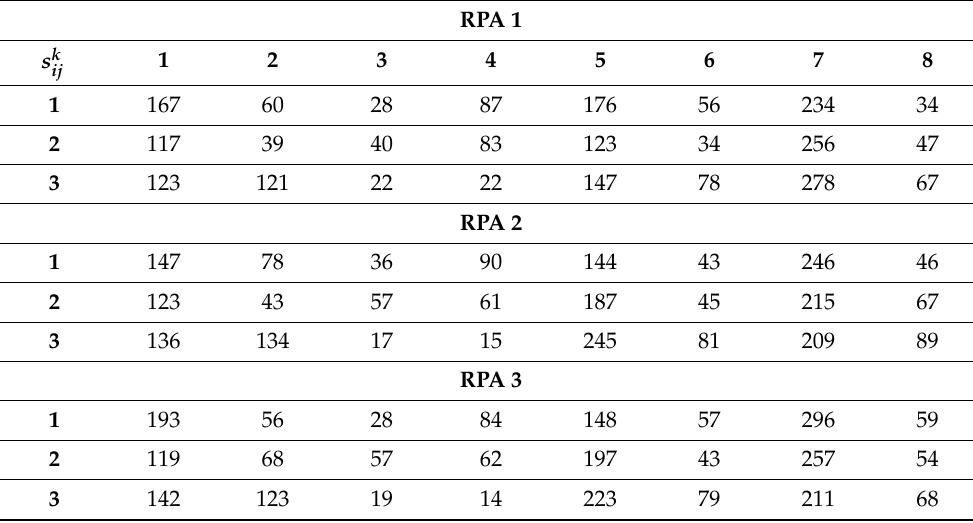
matrix through the AHP method. ij